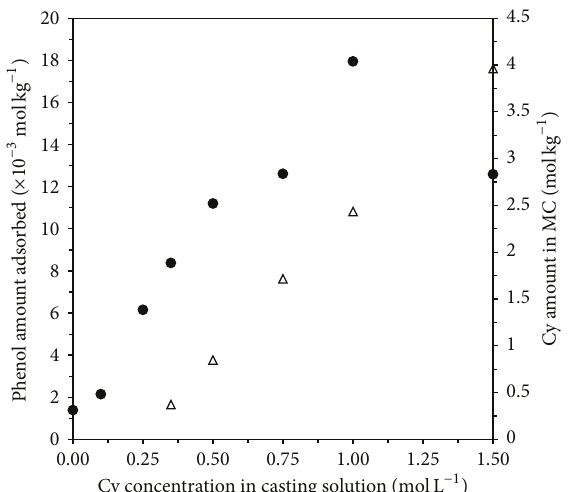
Figure 3: Phenol extraction to CA-MC-Cy prepared with several casting solutions containing different concentrations of Cyanex 923 ( e ) and Cy amounts in MC calculated from IR analysis ( △ ). Experimental conditions: 50 mL of phenol at 25 mgL −1 (pH = 6 ), 0.25 g of CA-MC-Cy, 7 hours of experimental time.